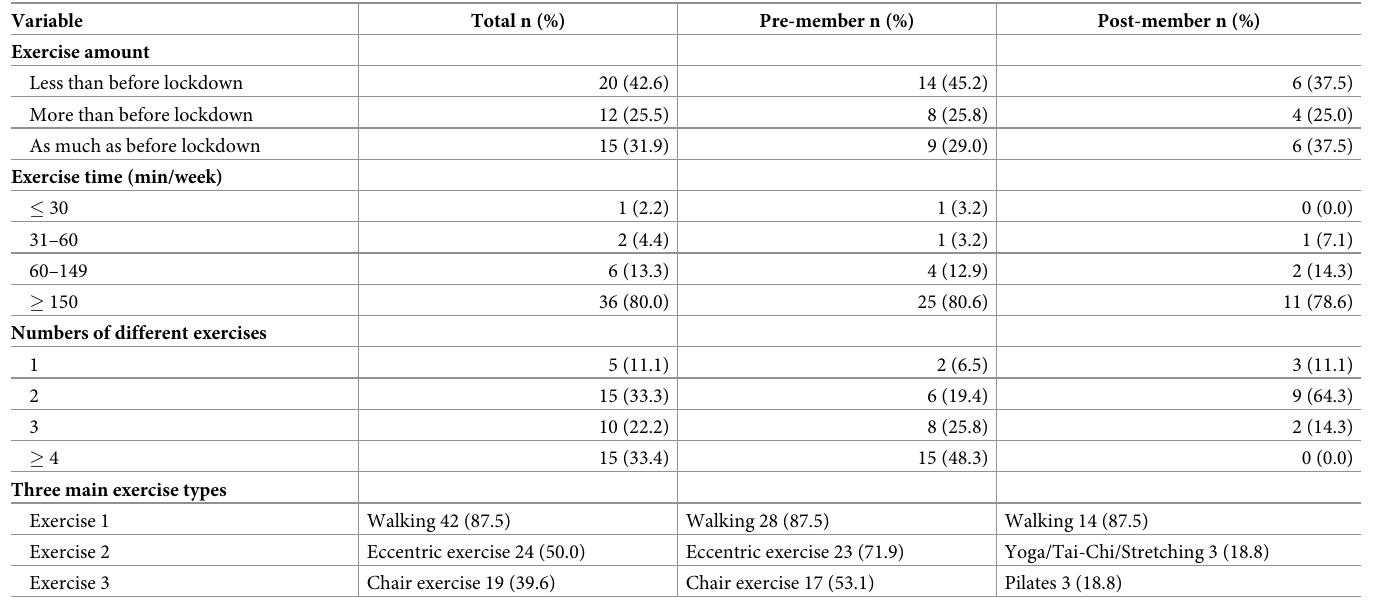
Table 1. Self-reported exercise experience during the first lockdown in April 2020 with Demographics of Questionnaire Respondents in Perth, Western